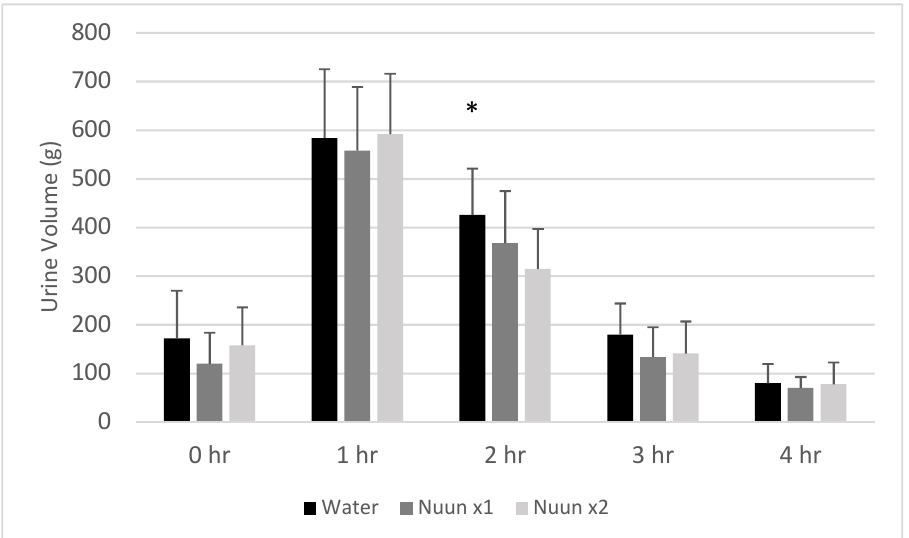
Figure 3. Urine volume of 18 men and women at individual times through four hours after consuming water only and Nuun + water; Values are mean ± standard deviation; hr is hour(s) after condition ingestion, Nuun x1 is Nuun beverage at normal concentration, Nuun x2 is Nuun beverage at double concentration; * Water higher than Nuun x1 ( p = 0.05) and Nuun x2 ( p = 0.0002); No other differences of statistical significance noted ( p > 0.05).